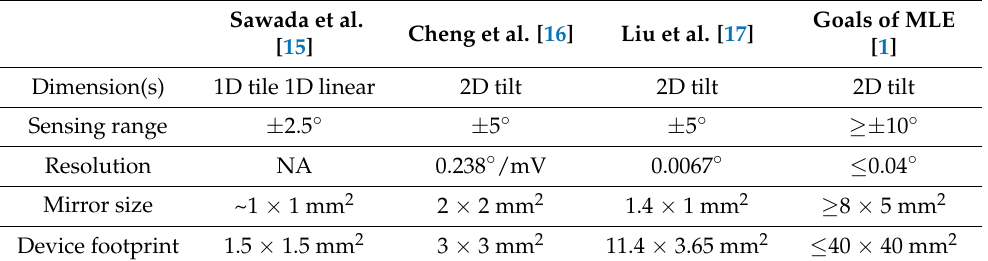
Figure 1. The optical arrangement inside conventional laser engravers. Table 1. Scanning mirrors with embedded sensors made by QPD and MOEMS, as reported in the surveyed literature.